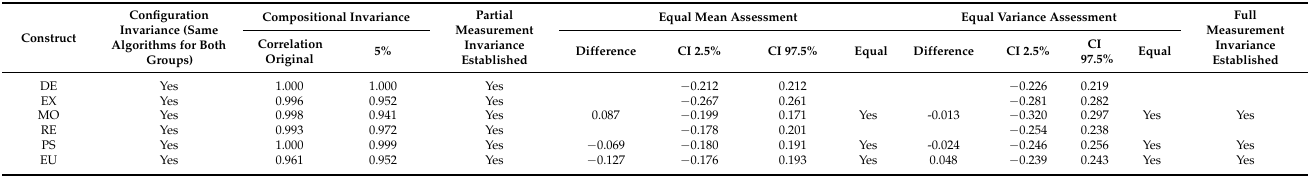
Table 8. Results of invariance measurement testing using permutation.